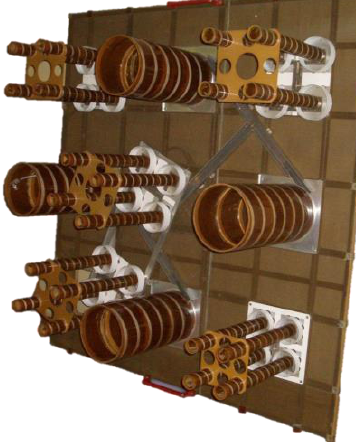
Fig 2. The on – board helical antenna array.